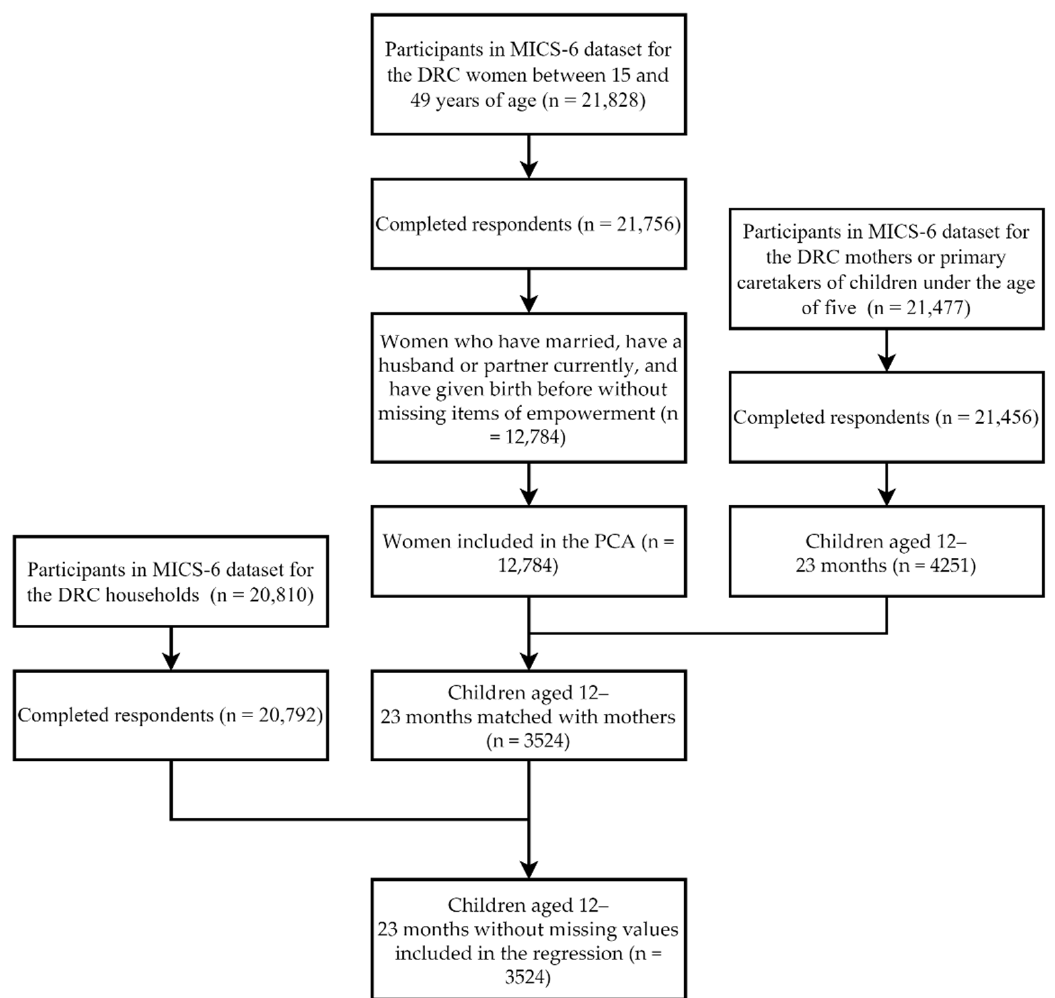
Figure 1. Flowchart of the selection process.